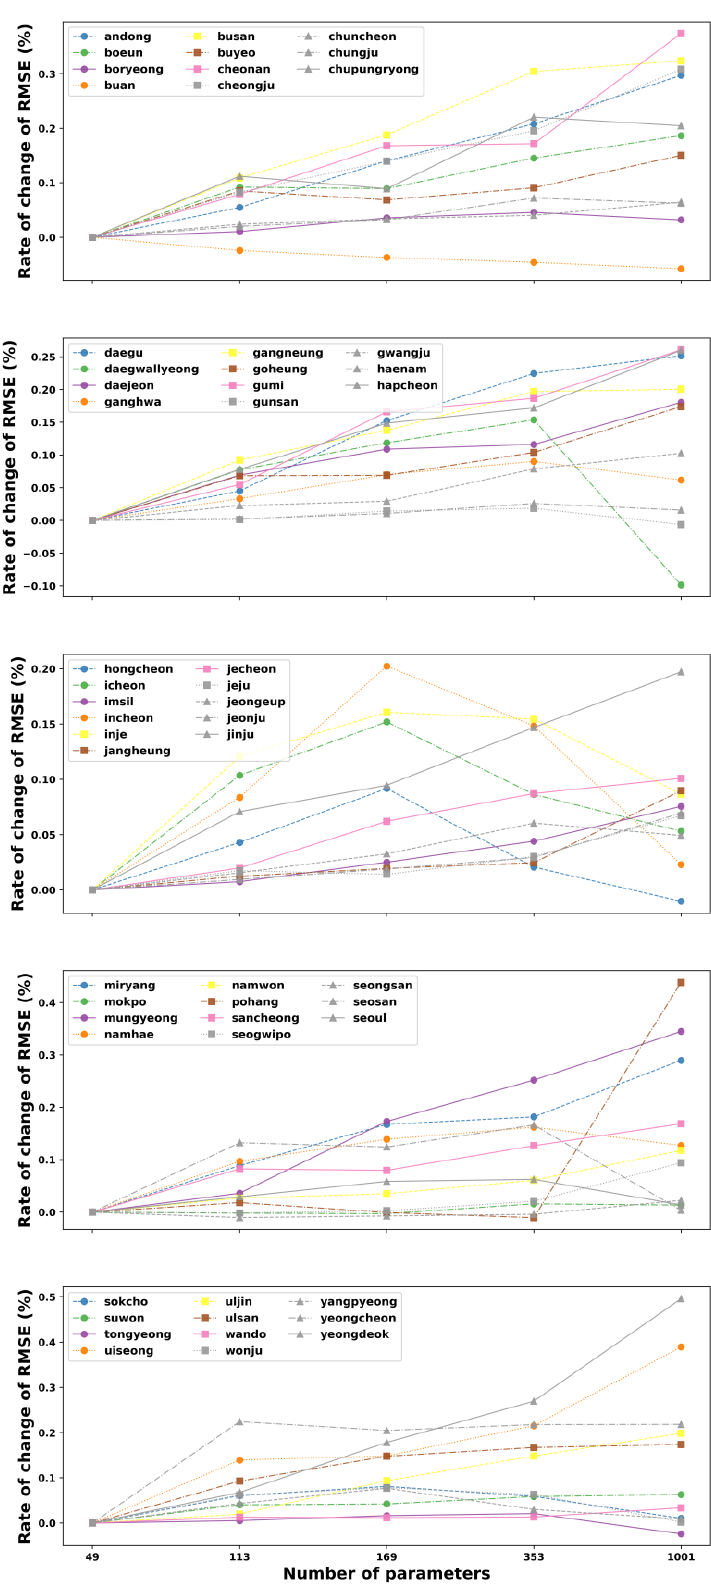
Figure 3. The rate of change of mean root mean square error (RMSE) of the 1-hidden layer ANN corresponding to 49, 113, 169, 353, and 1001 trainable parameters for the test data for all 55 stations in South Korea.